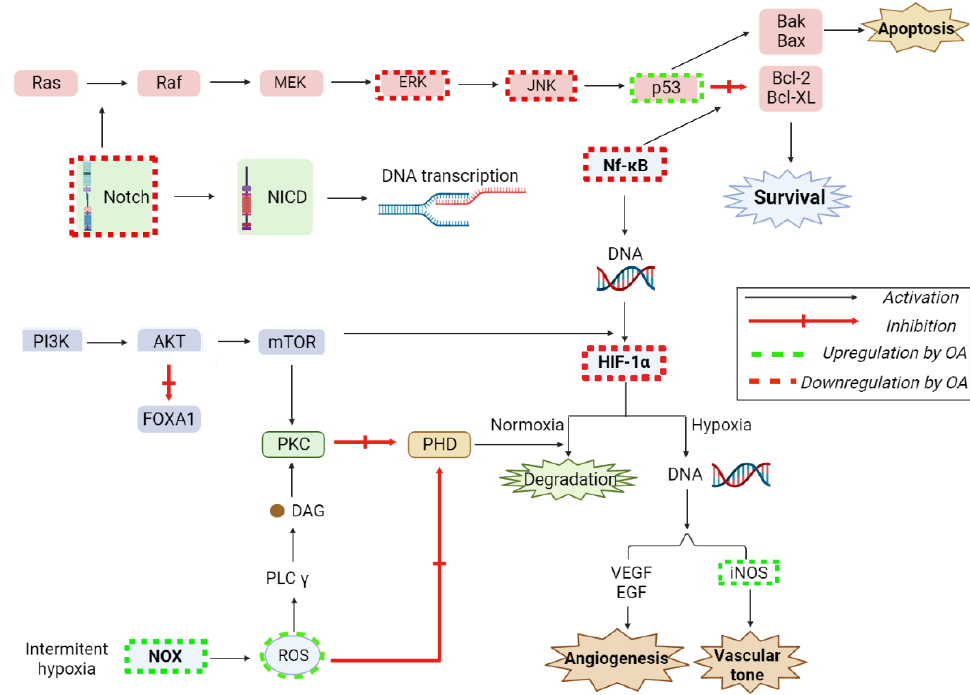
Figure 10. Schematic representation of the reported anticancer mechanisms of OA; key signaling pathways targeted by OA in cancer: PI3K/Akt pathway up-regulation -> inhibition of cell migration; Notch signaling pathway inhibition -> inhibition of cell proliferation; NF-kB signaling pathway suppression -> anti-inflammatory effect; ERK/JNK/p38 pathway activation -> induction of apoptosis. Created with BioRender.com (accessed on 8 May 2022).